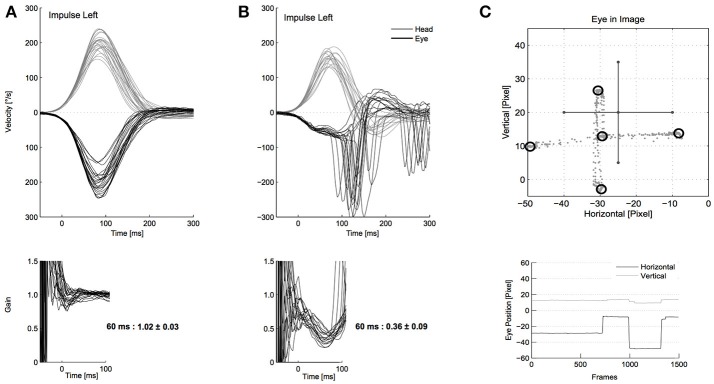
Video head impulse test (vHIT) examples with good technical quality. (A) Shows a normal video head impulse test (vHIT) with the eye movement (black, top) matching the head movement (gray, top), resulting in a gain at 55–65 ms around 1 (bottom). Head velocity is sufficient (around 150–250°/s) and there are no signs of restrictive mistakes. (B) Shows a vestibular deficit with reduced gain, covert, and overt re-fixation saccades. (C) Shows a successful calibration with the eye movements (gray dots, top) forming a cross, accumulating in the five laser points (black circles, top). In the bottom of (C) some original eye movement recordings during calibration are shown.